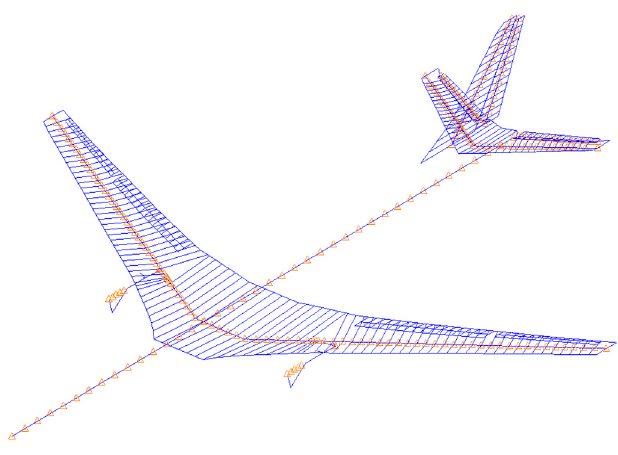
Figure 5. Condensed FE model of the XRF1-DLR-C.